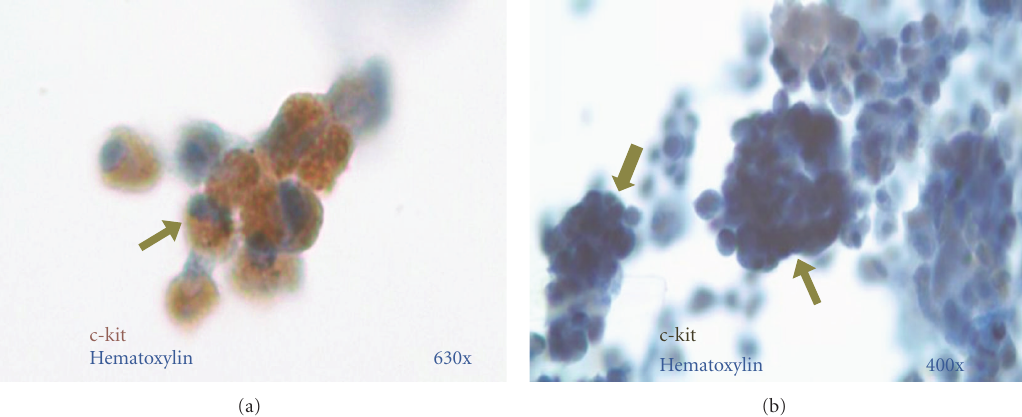
Figure 3: Identification of emigrated cells as c-kit positive . (a) Cluster of c-kit positive cells from a cytospin preparation after 28 days in culture (c- kit positive cells (light- and dark-brown arrow) visualized using reporter chromogen DAB with nuclear hematoxylin counterstain (light blue). Magnification × 630. (b) Representative cardiosphere composed of multiple cells (arrows) that were predominantly c-kit positive (brown to black-nickel-toned DAB and light blue nuclear hematoxylin counterstain). Magnification × 400. Table 1: Numbers of immunoselected hc-kit positive cells/g from right atrial appendage tissues of 3 patients with chronic heart failure. Time in culture